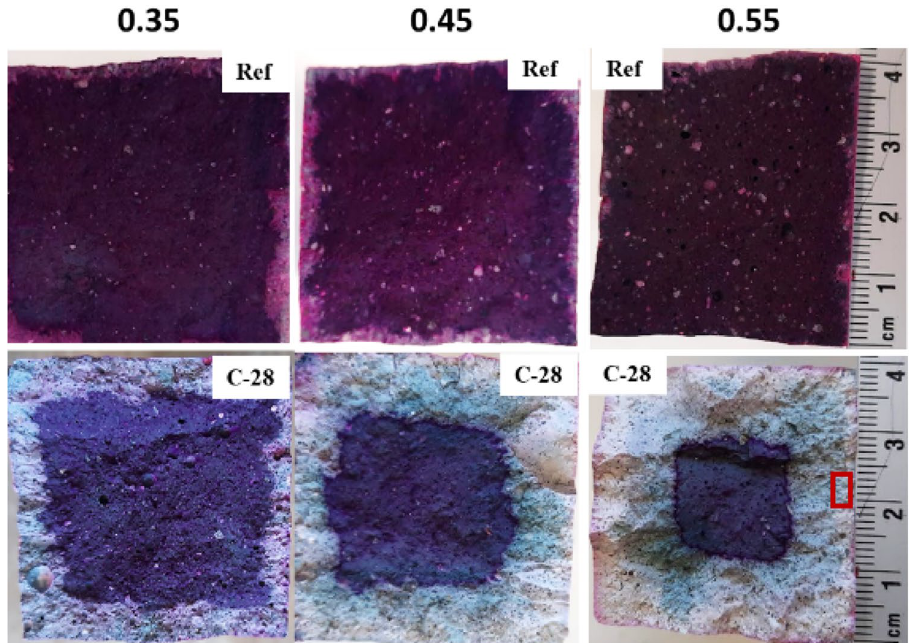
Figure 1. Example of carbonation depth determined by phenolphthalein spraying of sample after preconditioning (Ref) and 28 day carbonated (C-28) samples. Pink color indicates the uncarbonated zone. The red rectangular indicates the location to take sub-samples for